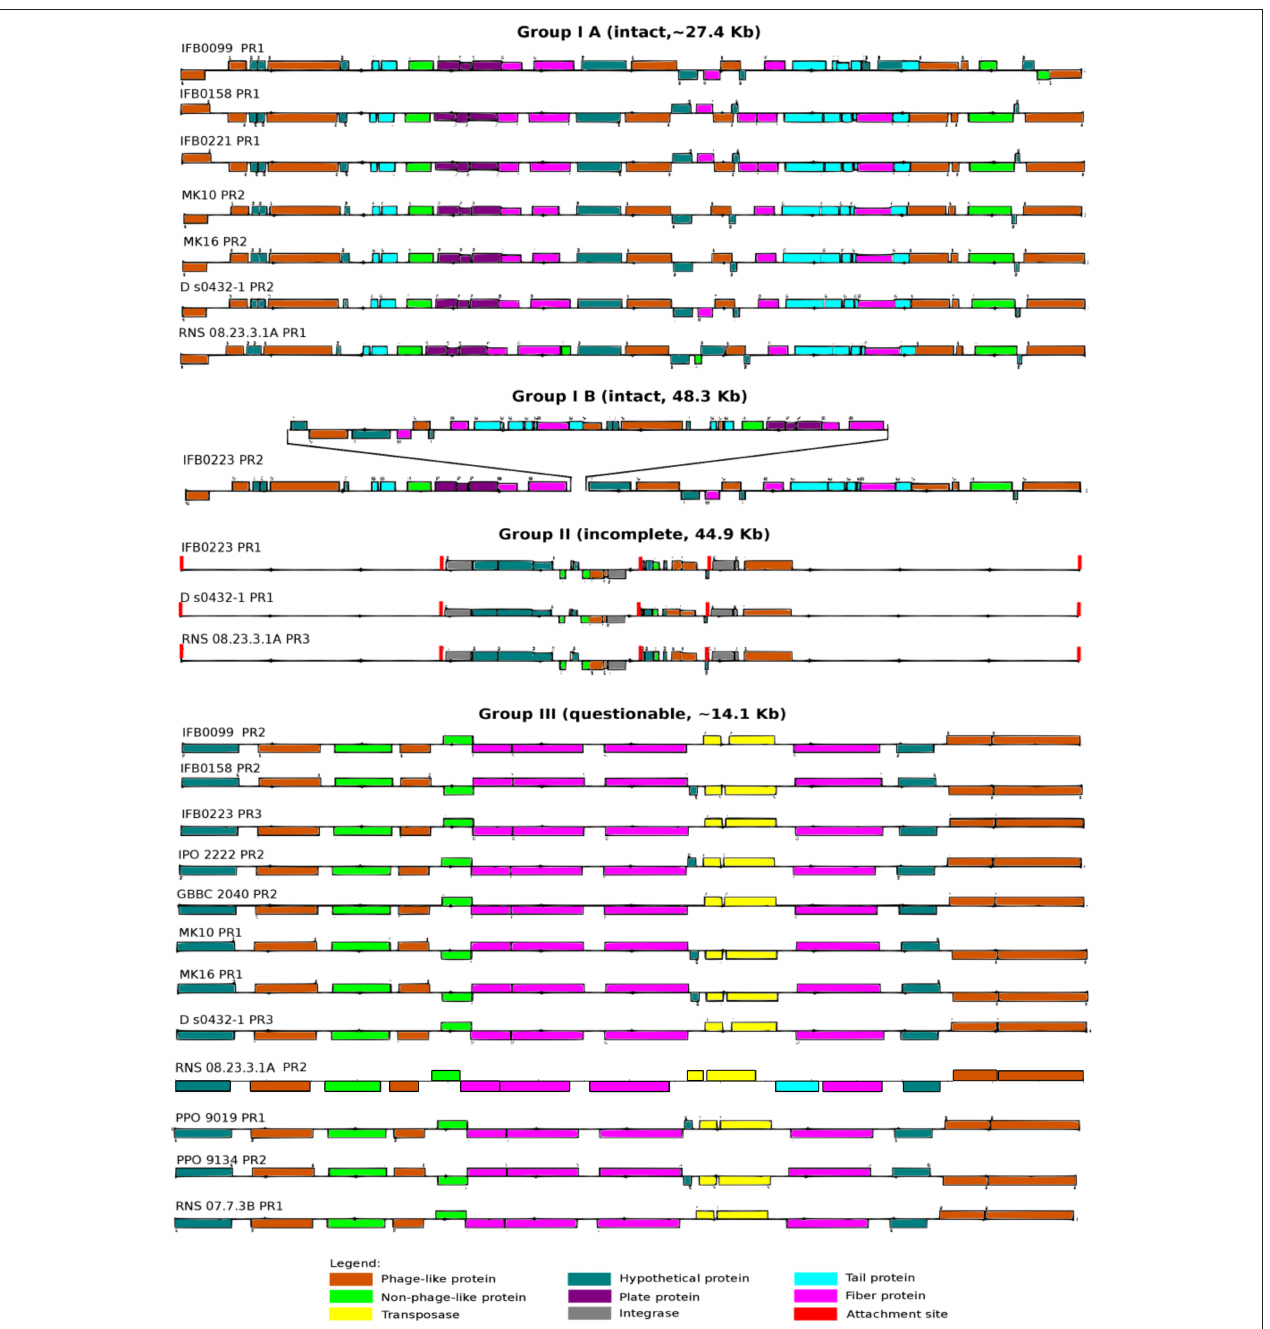
FIGURE 6 | Prophages present in the D. solani genomes. Prophages are divided into three groups: intact (IA and IB), incomplete (II) and questionable (III) on the basis of structural analysis based on data provided by PHAST on-line web server (http://phast.wishartlab.com/; Zhou et al., 2011).